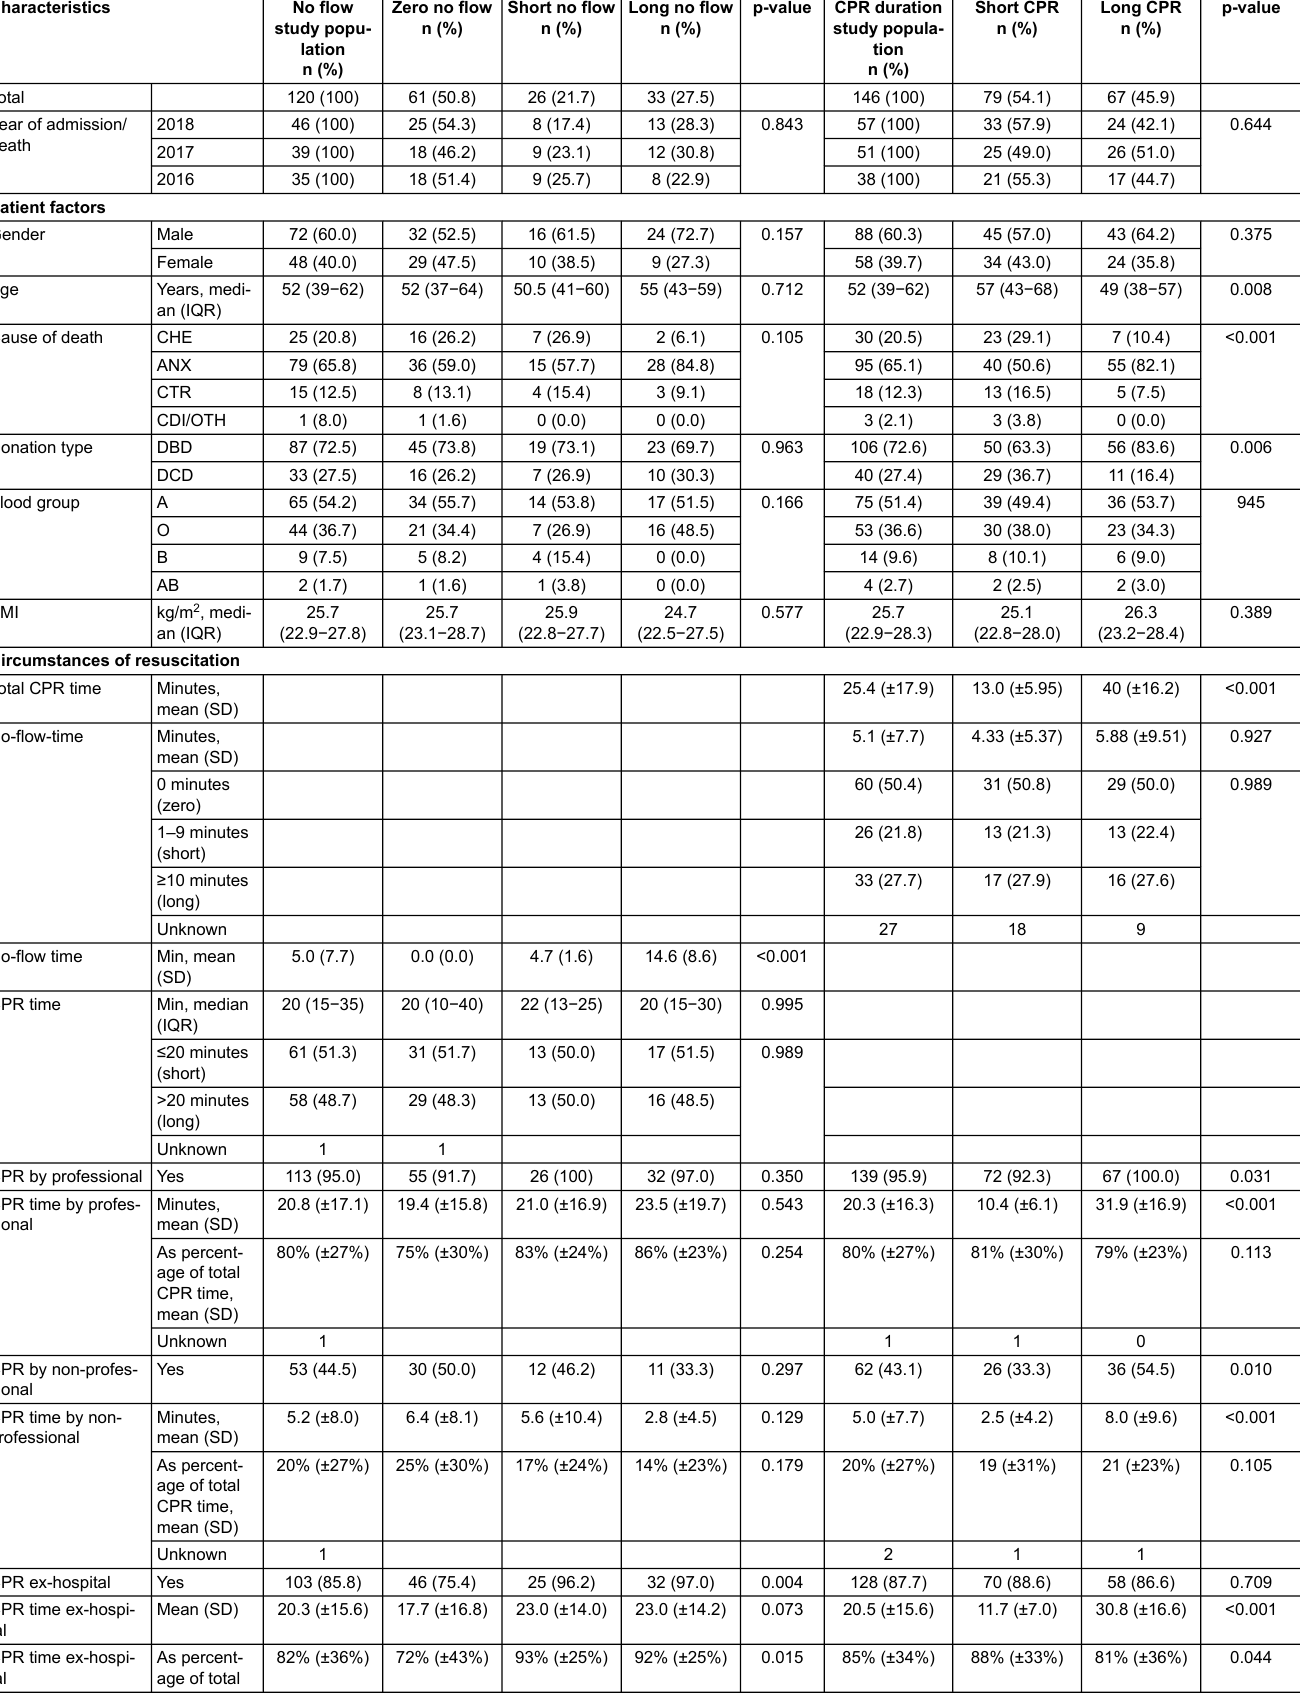
Table S1: Complete table for the analysis of the effect of CPR duration and no-flow time; included are only utilised donors (at least one organ transplanted) for whom either the duration of no-flow time, or the duration of CPR was documented.